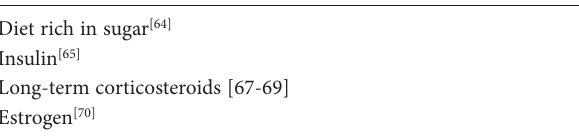
Table 3. Drugs increasing the release of entropy in the form of bio- mass.